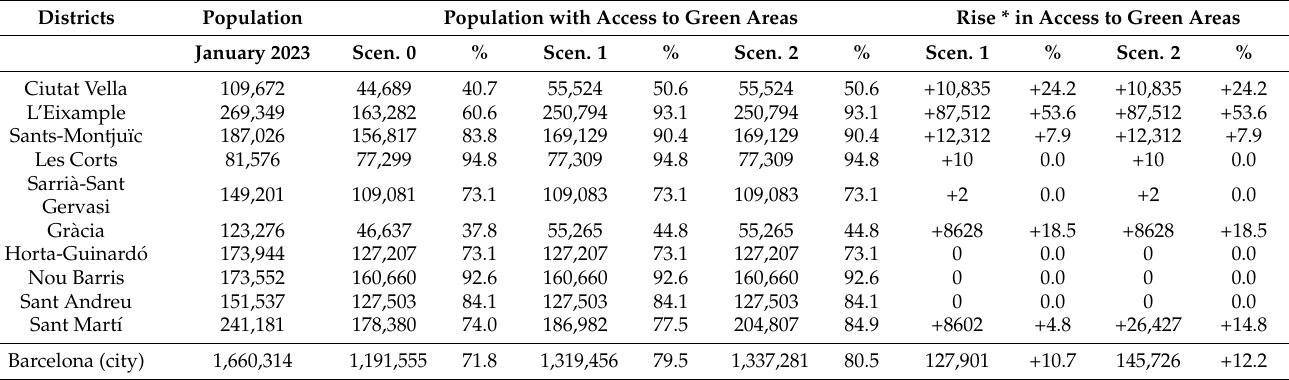
Table 1. Population with access to green areas in the districts of Barcelona, in the current situation (scenario 0), with the green axes and square gardens implemented in L’Eixample district in 2030 (scenario 1), and with the green axes and square gardens extended to Sant Mart í district (scenario 2). Source: the authors with original population data from Open Data BCN